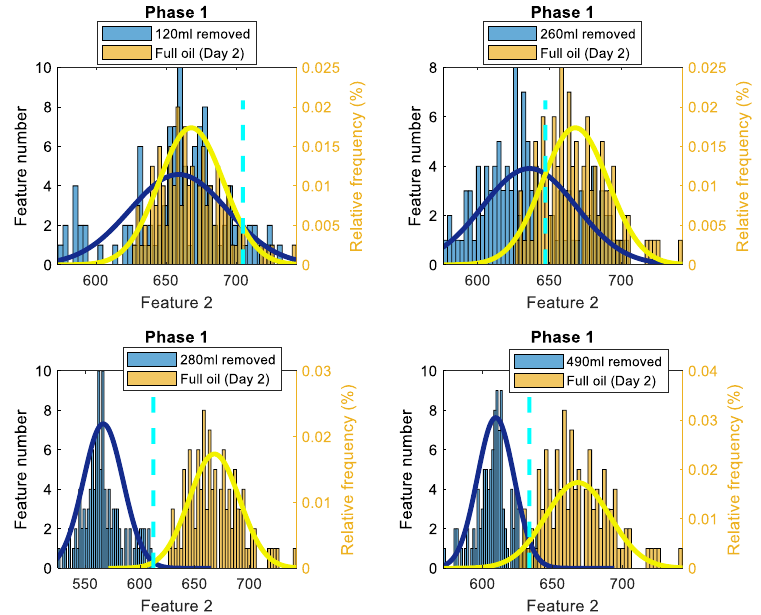
Figure A7. Histograms of Feature 2 for phase 1 of the current signals, comparing the standard oil level (Day 2) to 120 mL, 260 mL, 280 mL and 490 mL of removed oil cases.